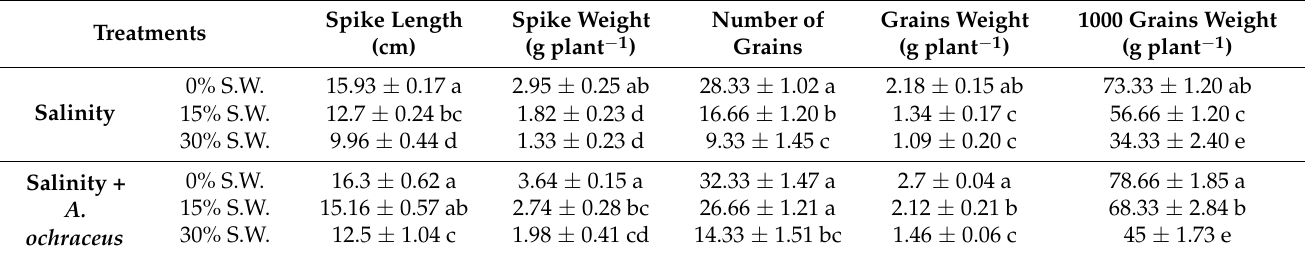
Table 4. Effect of seawater irrigation, A. ochraceus application, and their interactions on yield characteristics of barley plants. Each value represents the mean ± standard error. The letters indicate significant differences between the treatments according to an LSD test at p < 0.05.